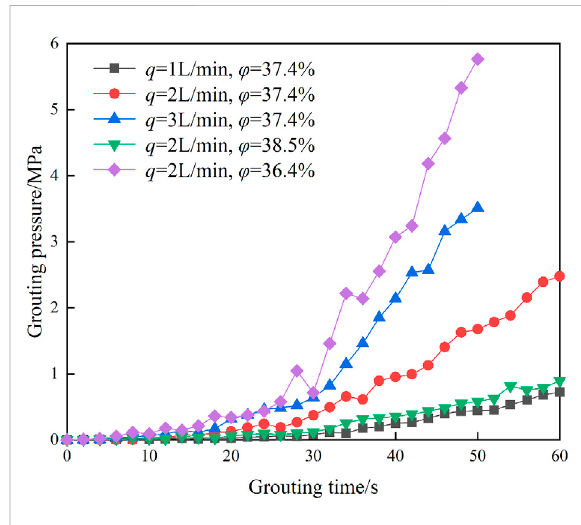
FIGURE 5 Grouting pressure variation curve under different conditions.